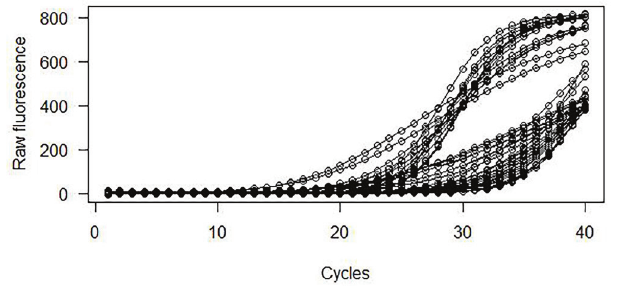
Figure 6 - Amplification of mesenteric lymph nodes tissue